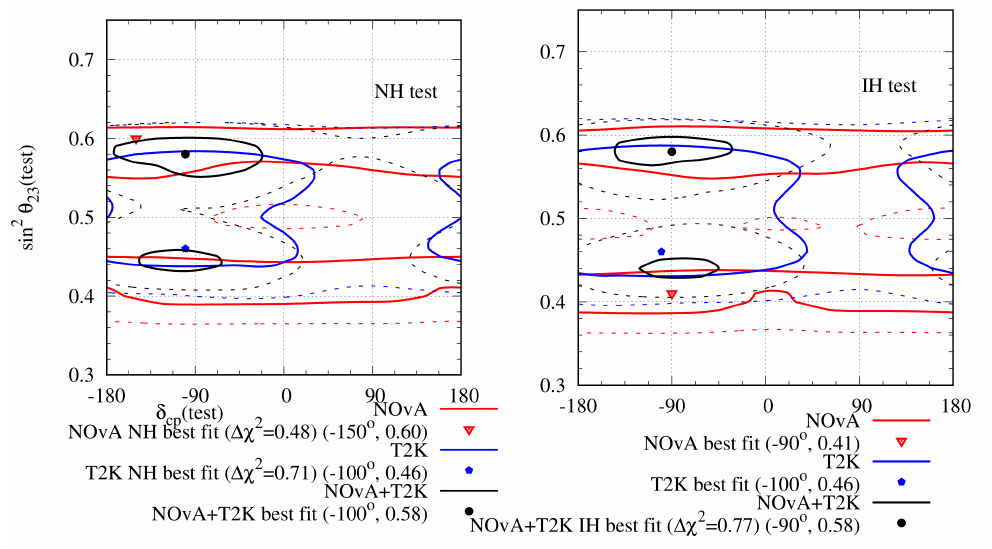
Figure 15. Allowed region in the sin 2 θ 23 − δ CP plane after analysing NO ν A and T2K complete data set with the NSI hypothesis. Only the effect of (cid:101) e τ = | (cid:101) e τ | e i φ NSI e τ has been considered. The left ( right ) panel represents test hierarchy to be NH (IH). The red (blue) lines indicate the results for NO ν A (T2K) and the black line indicates the combined analysis of both. The solid (dashed) lines indicate the 1 σ (3 σ ) allowed regions. The minimum χ 2 for NO ν A (T2K) with 50 (88) bins is 48.59 (93.73) and it occurs at IH. For the combined analysis, the minimum χ 2 with 138 bins is 146.38 and it is at NH. As before, we have emphasised our argument about the resolution of the tension between NO ν A and T2K with the inclusion of NSI due to (cid:101) e τ through bi-event plots in Figure 16. At the best-fit point of the combined analysis, the value of | (cid:101) e τ | is 0.73. However, there is a nearly degenerate best-fit point at | (cid:101) e τ | = 0.19 with ∆ χ 2 = 0.13. As a result of the stronger constraint against (cid:101) e τ being large from IceCube data [150], we consider the combined best-fit point at | (cid:101) e τ | = 0.19. It is clear that for NH, inclusion of NSI due to (cid:101) e